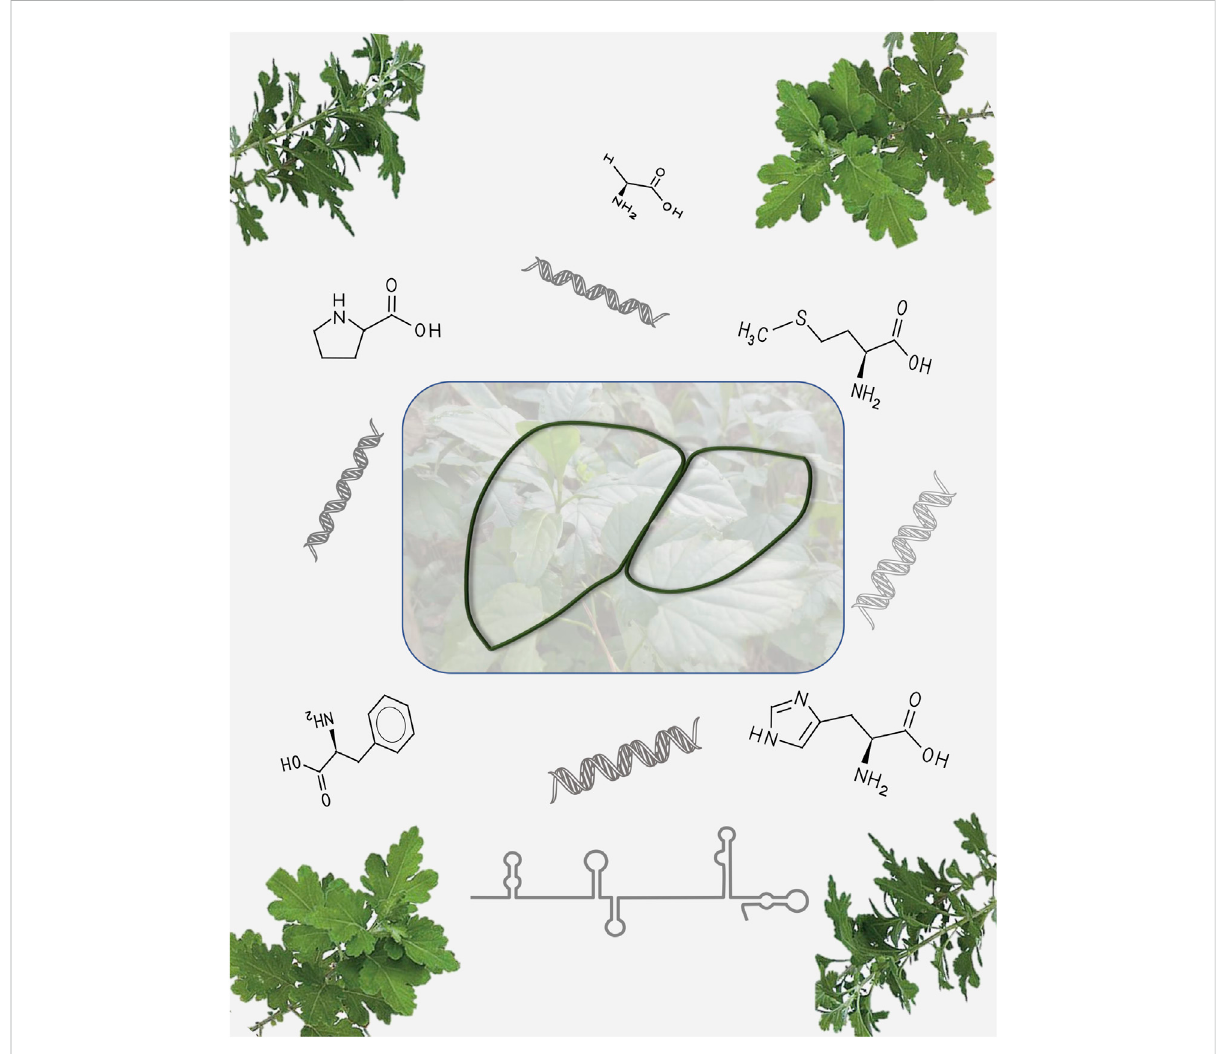
FIGURE 1 Nonalcoholic fatty liver disease: from pathogenesis to phytomedicine based on omics